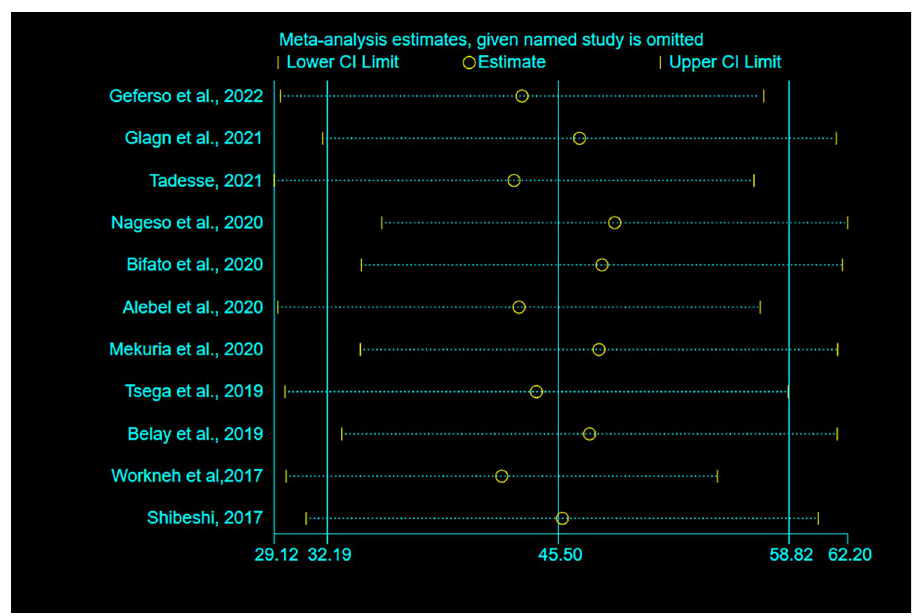
Fig 6. Sensitivity analysis for pooled estimates of CBHI enrollment in Ethiopia, 2017–2022.